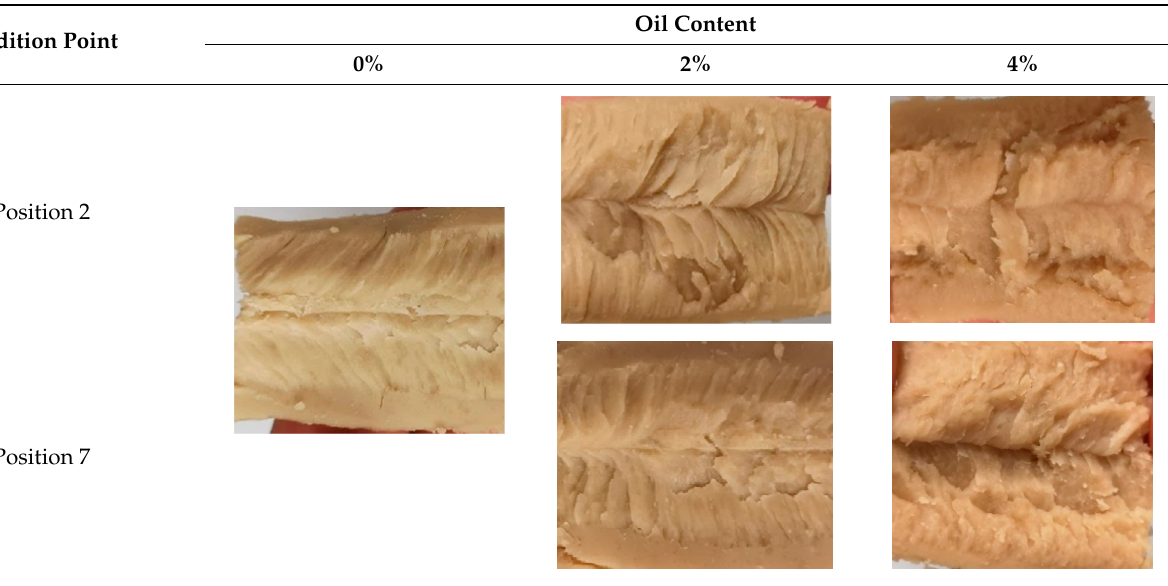
Table 2. Micro-computed tomograph (micro-CT) images of freeze-dried extrudate samples. Influence of oil content on the anisotropic structure as a function of the oil addition point (position 2 and 7). The barrel temperature was 120 °C, screw speed was 400 rpm, total mass flow was 10 kg/h and water content was 51–53% for all samples.